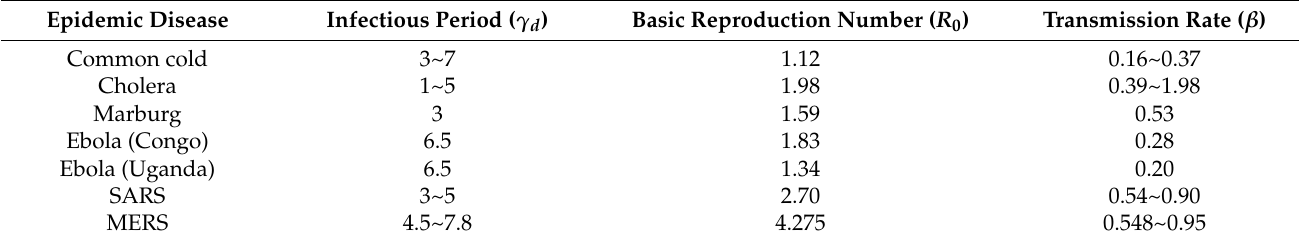
Figure 6. Extinctive spreading parameter maps ( k = 2, 5, 7, and 10) reveal the relations between extinctive spread regions and the parameters β , γ d , and k , where the extinctive region is depicted in brown and the safe region is presented in blue. Colored bar represents extinctive spread score, which is calculated by dividing the total number of simulation trials by the number of extinctive spread cases. In low β and low γ d cases, infective nodes become recovered nodes before transmitting the disease, causing disconnection within the network and preventing extinctive spread. In low β and high γ d cases, infective nodes try to transmit the disease to adjacent susceptible nodes until these nodes become recovered; however, successful transmission does not occur as the transmission rate is too low. Moreover, the disease begins to subside due to the lack of new infective nodes. As the speed of epidemic spreading is faster in dense (large k ) networks than in sparse networks, the area of extinctive spread increases when k increases. The advent position of fatal contagious disease is presented on the extinctive spreading parameter maps, and the range of parameters in several epidemics forms a band of diseases above the extinctive spreading probability map. Each epidemic has its own disease band. Here, common cold, cholera, Marburg, two types of Ebola (Congo and Uganda), severe acute respiratory syndrome (SARS), and Middle East respiratory syndrome (MERS) are mapped. The dark brown region reveals that any epidemic with these parameters may presumably infect all nodes in the scale-free network with an average degree of k . Table 1. Epidemic parameters of infectious